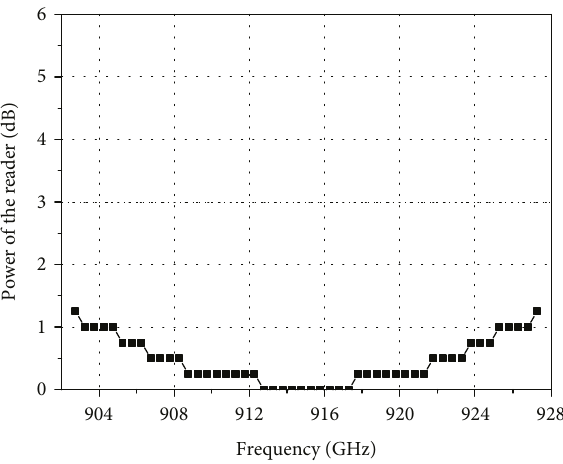
Figure 10: Power bandwidth of the tag